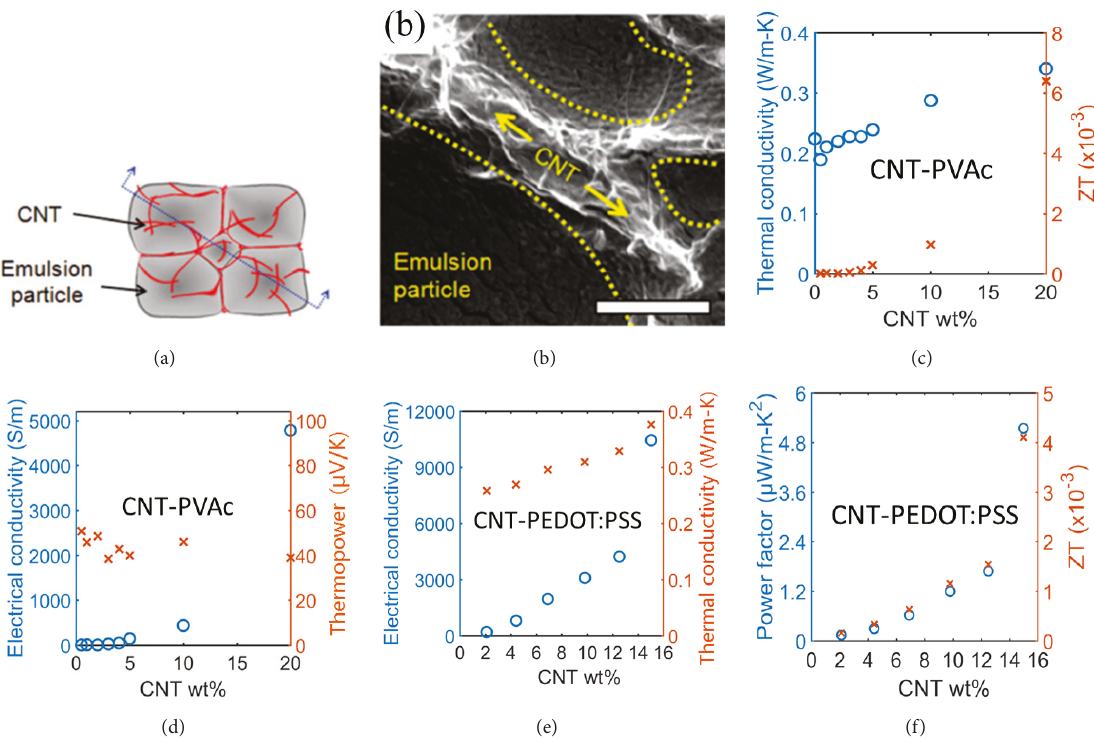
Figure 12: ((a) and (b)) The schematic and SEM image of the CNT-PVAc composite [204]. (c)–(f) Thermal conductivity, ZT, electrical conductivity, and thermopower (Seebeck coefficient) of the CNT-PVAc or CNT-PEDOT:PSS composites as a function of the weight percent of CNT [204, 205]. Panels (a) and (b) are reproduced with permission